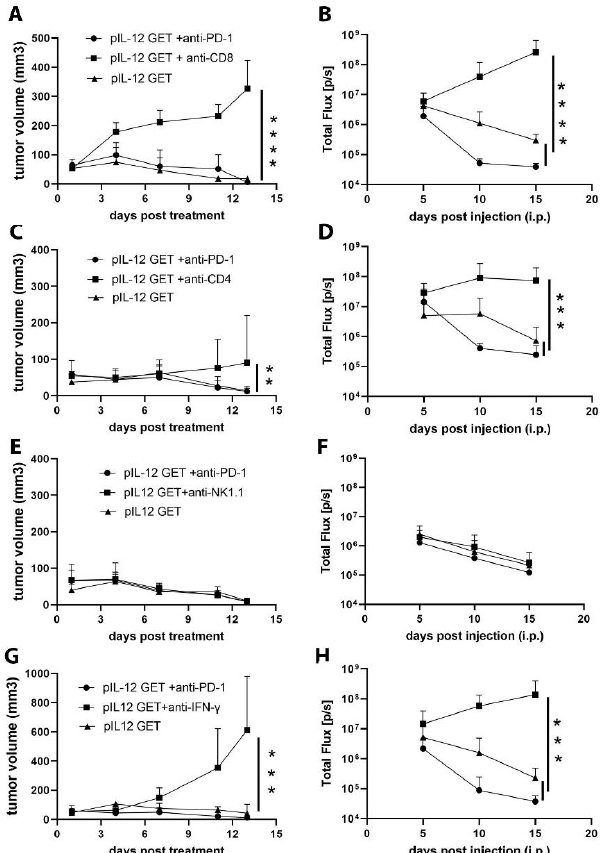
Figure 4. Combination therapy of pIL-12 GET and anti-PD1exerts an anti-tumor effect in a CD8- and CD4-dependent manner. Mice received i.p. injection of ( A , B ) anti-CD8, ( C , D ) anti-CD4, ( E , F ) anti-NK1.1 and ( G , H ) anti-IFN- γ on day -1, 0, 2, 4, 7, then followed by twice a week. ** p < 0.01; *** p < 0.001; **** p < 0.0001.